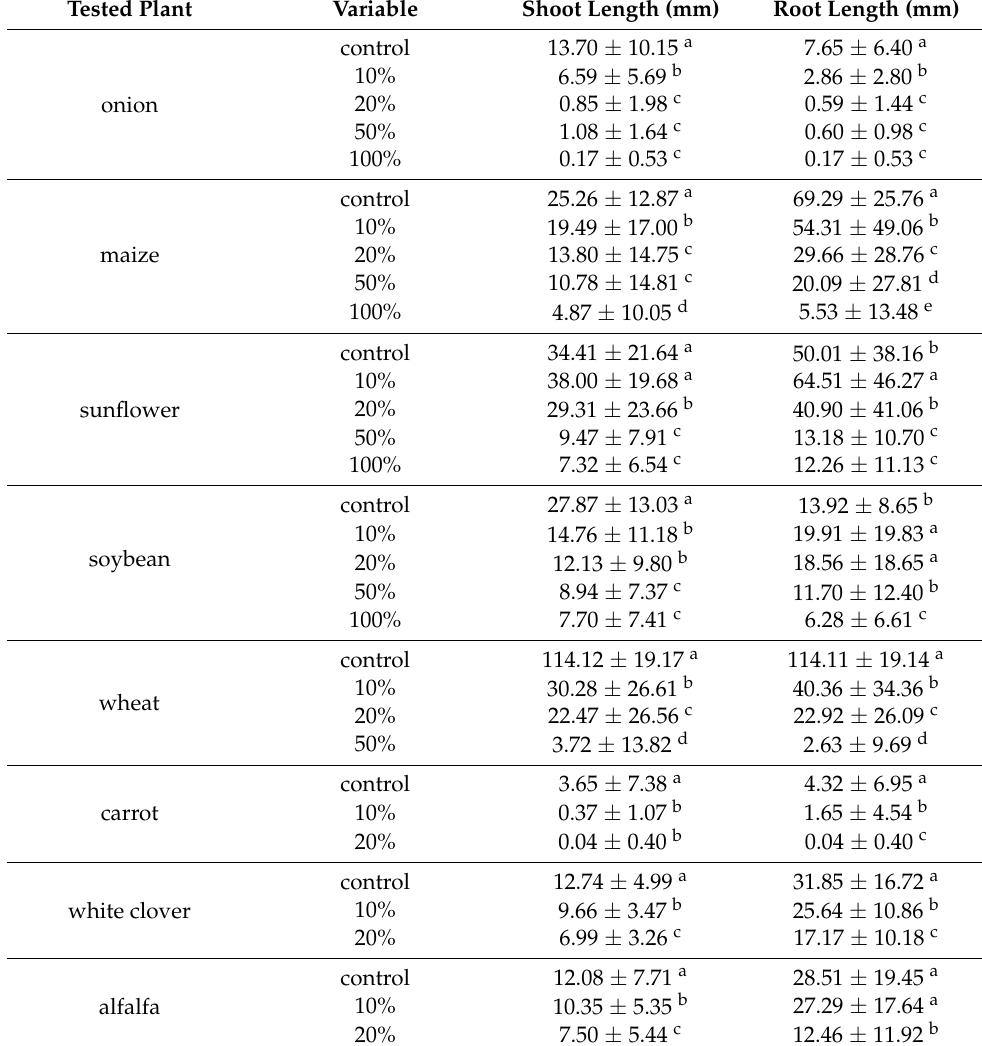
Table 3. The shoot and root seedling length of the field and vegetable crop species treated with 10, 20, 50, and 100% T. vulgaris hydrolate solutions. Tested